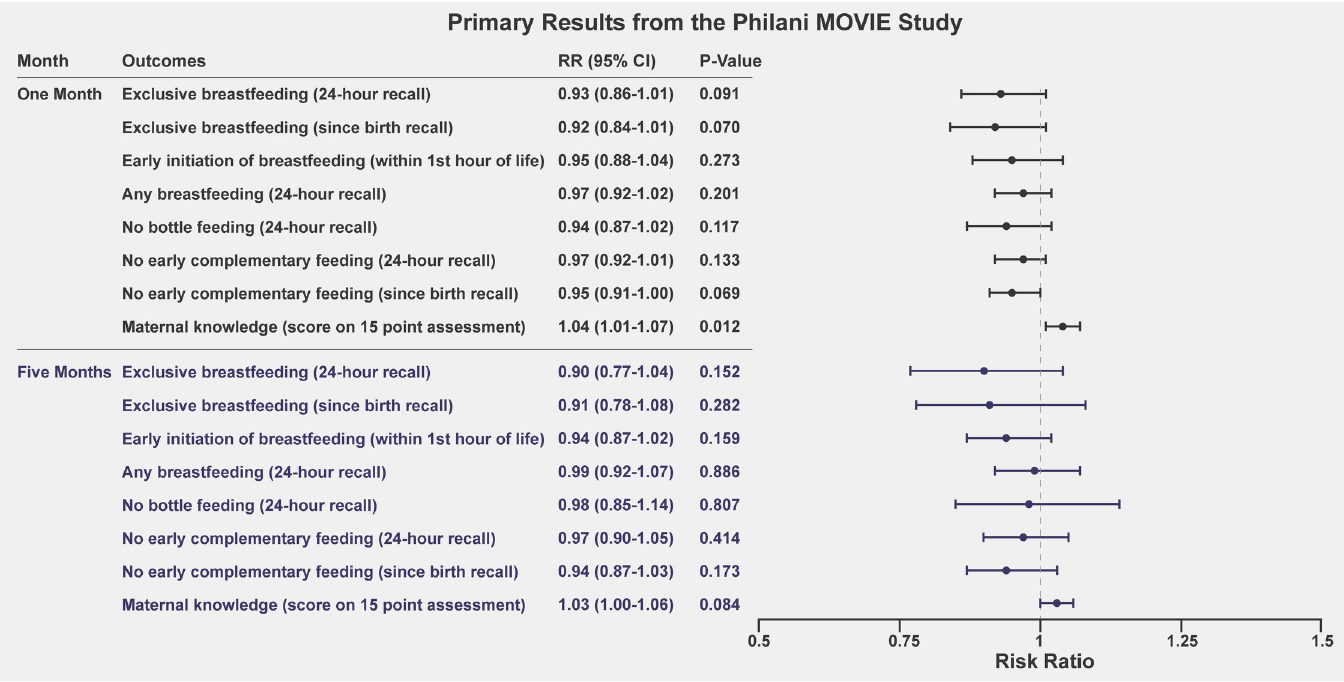
Fig 5. Infant feeding results at 1 month and 5 months. MOVIE, MObile Video Intervention for Exclusive breastfeeding; RR, risk ratio.